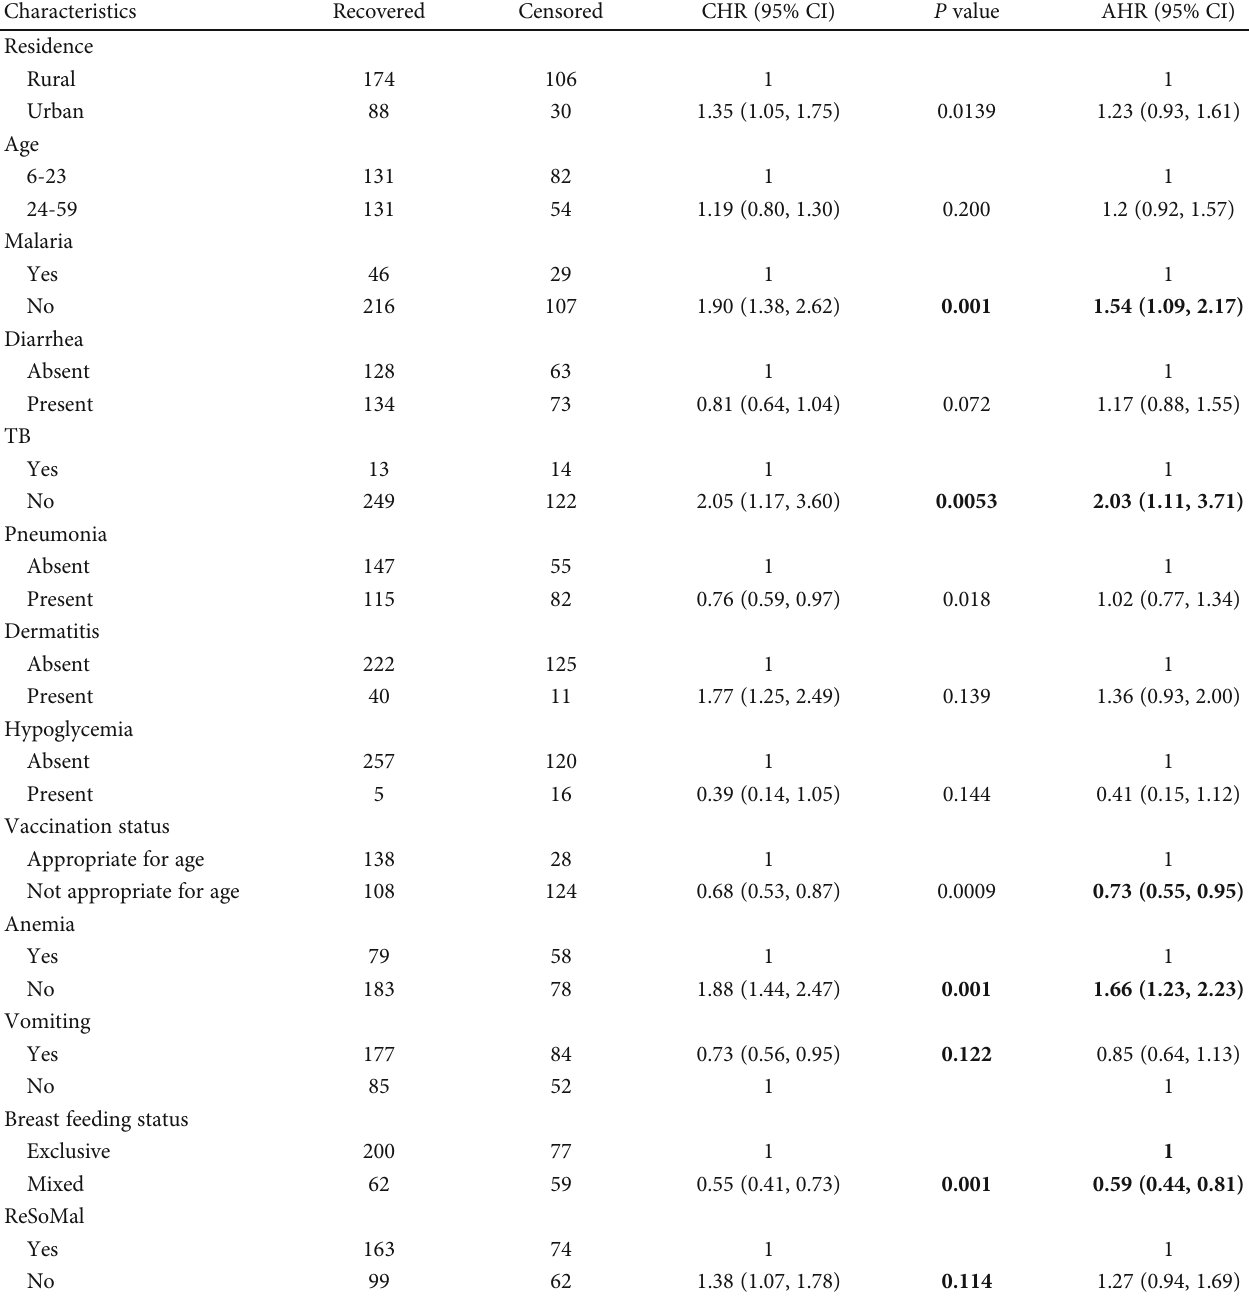
Table 5: Predictors of recovery time from severe acute malnutrition among 6 – 59-month-old children admitted in the therapeutic feeding center of Pawi General Hospital, northwest Ethiopia